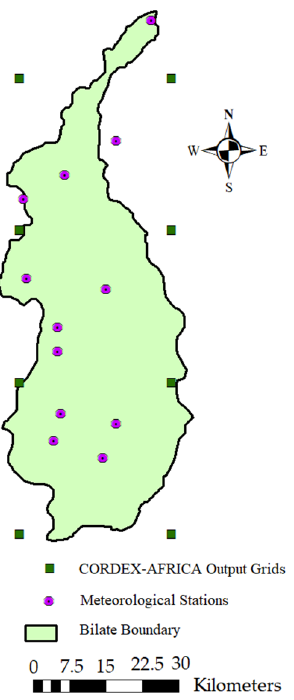
Figure 3. Locations of CORDEX-Africa output grid points in the Bilate watershed. Table 1. Description of the CORDEX-Africa Regional Climate Model (RCA4) simulations. Modeling Center